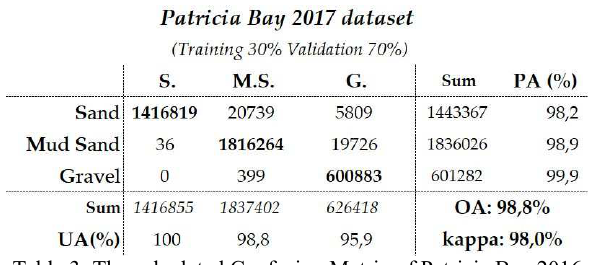
Table 3: The calculated Confusion Matrix of Patricia Bay 2016 as resulted from a RF classification.